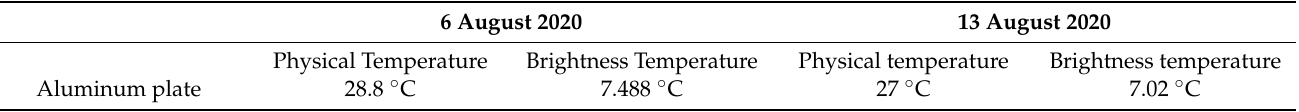
Table 2. Relationship between physical temperature and brightness temperature of aluminum